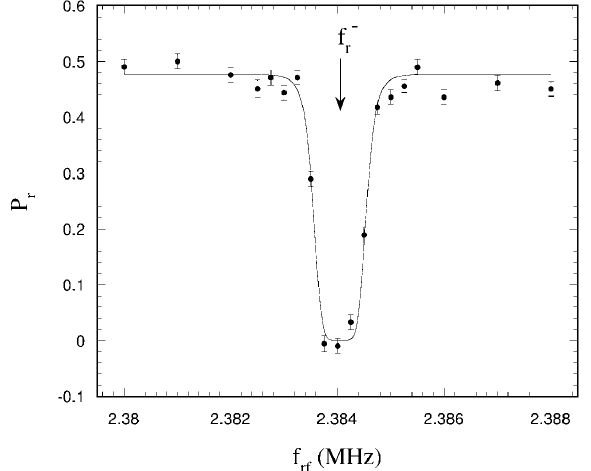
FIG. 2. The measured radial proton polarization at 120 MeV is plotted against the rf dipole’s frequency. The rf dipole’s R B dl was 0.06 T mm. The curve is a fit using a second-order Lorentzian. The arrow shows f 2 r